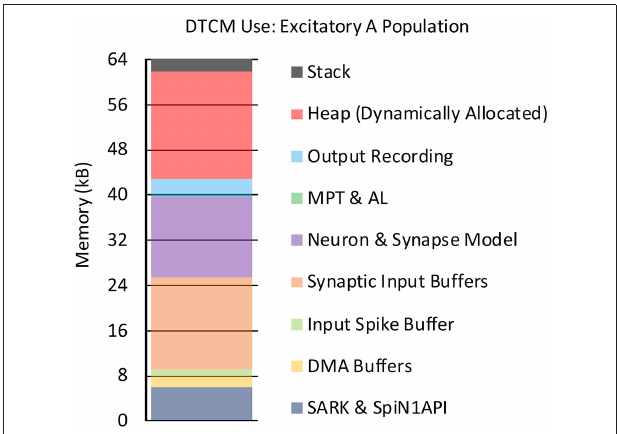
FIGURE 12 | DTCM footprint for neuron application simulating the Excitatory A population in Figure 3B